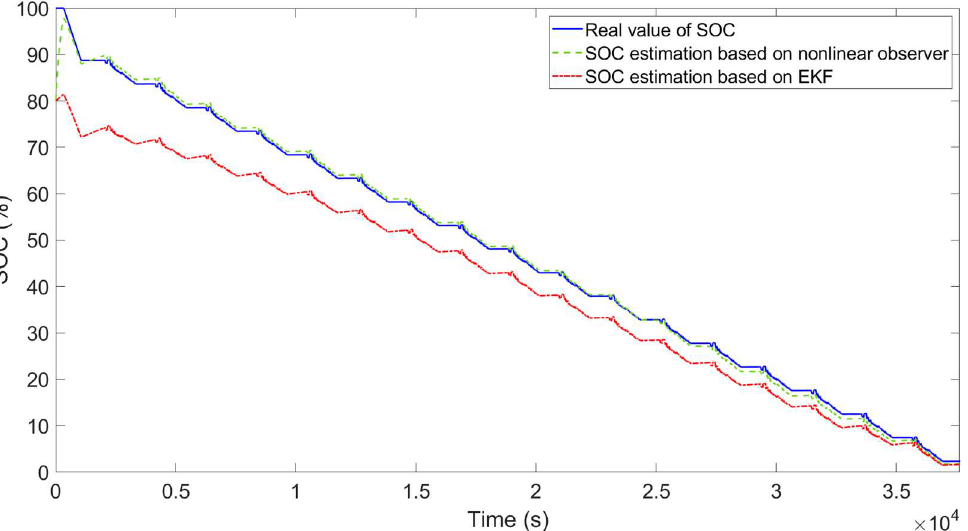
Figure 13. Comparison of SOC estimation based on non-linear observer and EKF in dynamic condition test 1 under random SOC initial value.